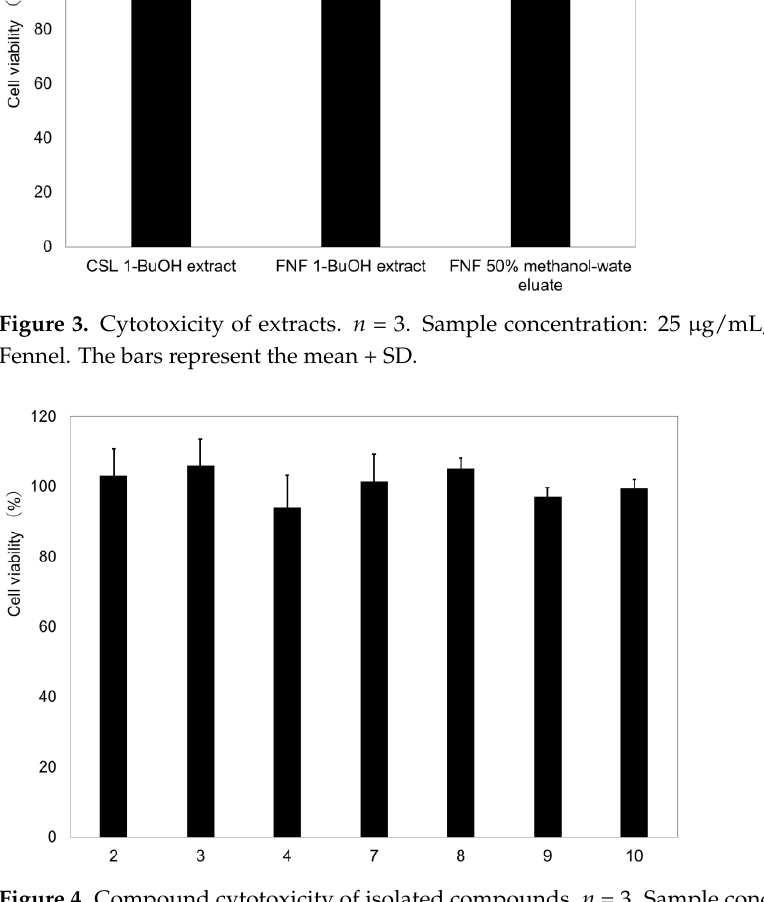
Figure 4. Compound cytotoxicity of isolated compounds. n = 3. Sample concentration: 25 µg/mL; compound 2 : chlorogenic acid, 3 : querucetin 3- O -glucopyranoside, 4 : (2 E , 6 R )-2, 6-dimethyl-2, 7- octadien-6-ol-1- O - β - D -glucopyranoside, 7 : syringin, 8 : 5,5 ’ -diallyl-2,2 ’ -diglucopyranosyl-3,3 ’ -di- methoxy diphenyl ether, 9 : querucetin 4 ′ - O -glucopyranoside, 10 : kaempferol 4 ′ -O-glucopyranoside. The bars represent the mean + SD.